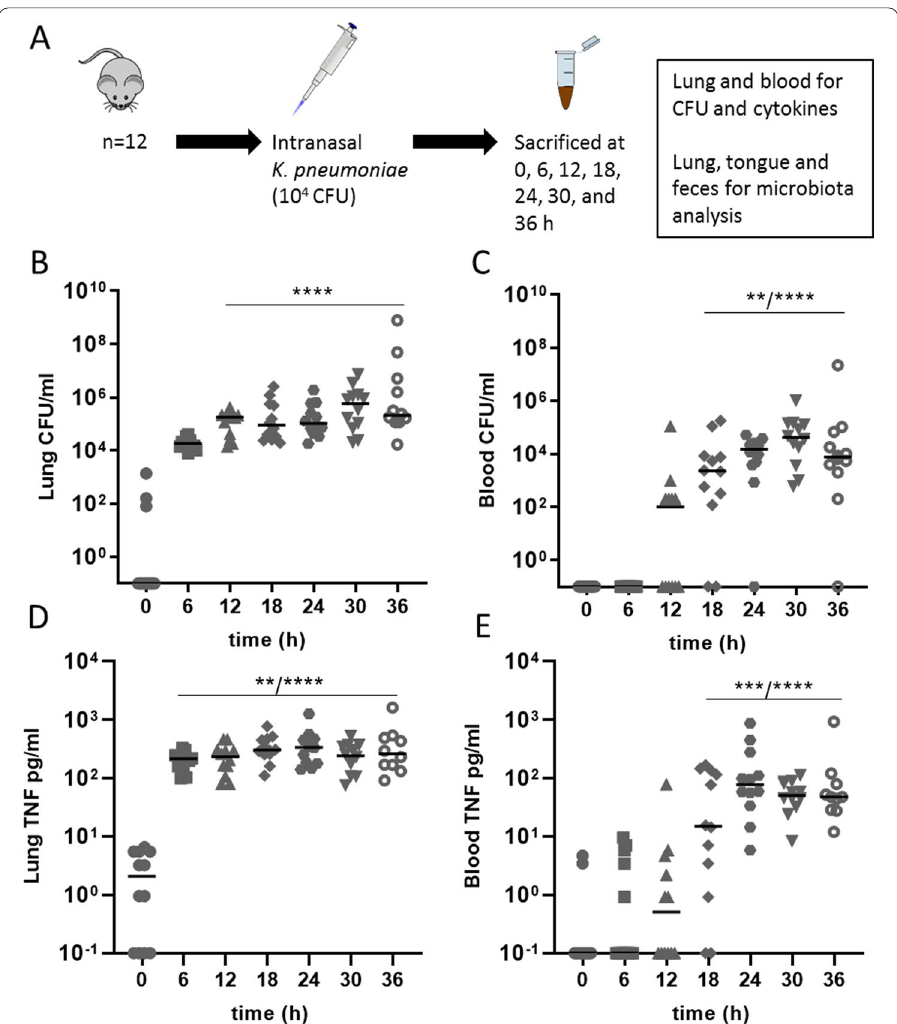
Fig. 1 Organ bacterial loads and cytokine levels during K. pneumoniae infection. a Experimental design. Mice received an intranasal inoculation with 10 4 colony forming units (CFU) of K. pneumoniae . A group was killed every 6 h, until 36 h ( n 10–12) at which time blood, lung, tongue and feces were collected, t = the control group. This model becomes lethal approximately 40 h post-inoculation ( a ). Pulmonary ( b ) and blood ( c ) CFU at 0 to 36 h post-inoculation. Tumor necrosis factor (TNF) of lung homogenate ( d ) and blood plasma ( e ) at 0 to 36 h post-inoculation. Data are shown as median, the top bar denotes at which time-points the data are significantly different from the 0-h group, the stars show the range of significance, p < 0.01 (**), p < 0.001 (***) and p < 0.0001